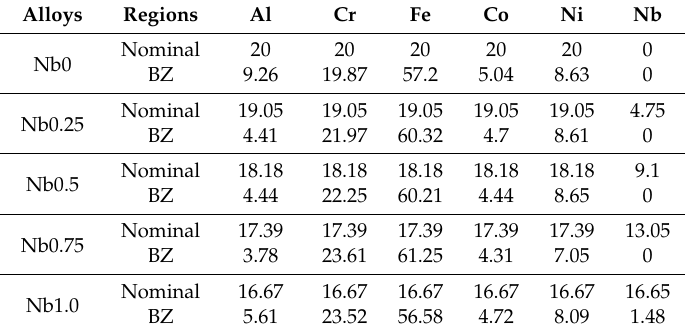
Figure 2. Micrographs of the cross-section and bonding zone of the alloy coating. ( a ) Cross-section, ( b ) bonding zone. CZ = cladding zone; BZ = bonding zone; HAZ = heat-affected zone. Table 2. Energy-dispersive spectroscopy (EDS) results of the bonding zone (BZ) for AlCoCrFeNiNb x (x = 0, 0.25, 0.5, 0.75, and 1.0) alloy coatings (at. %).